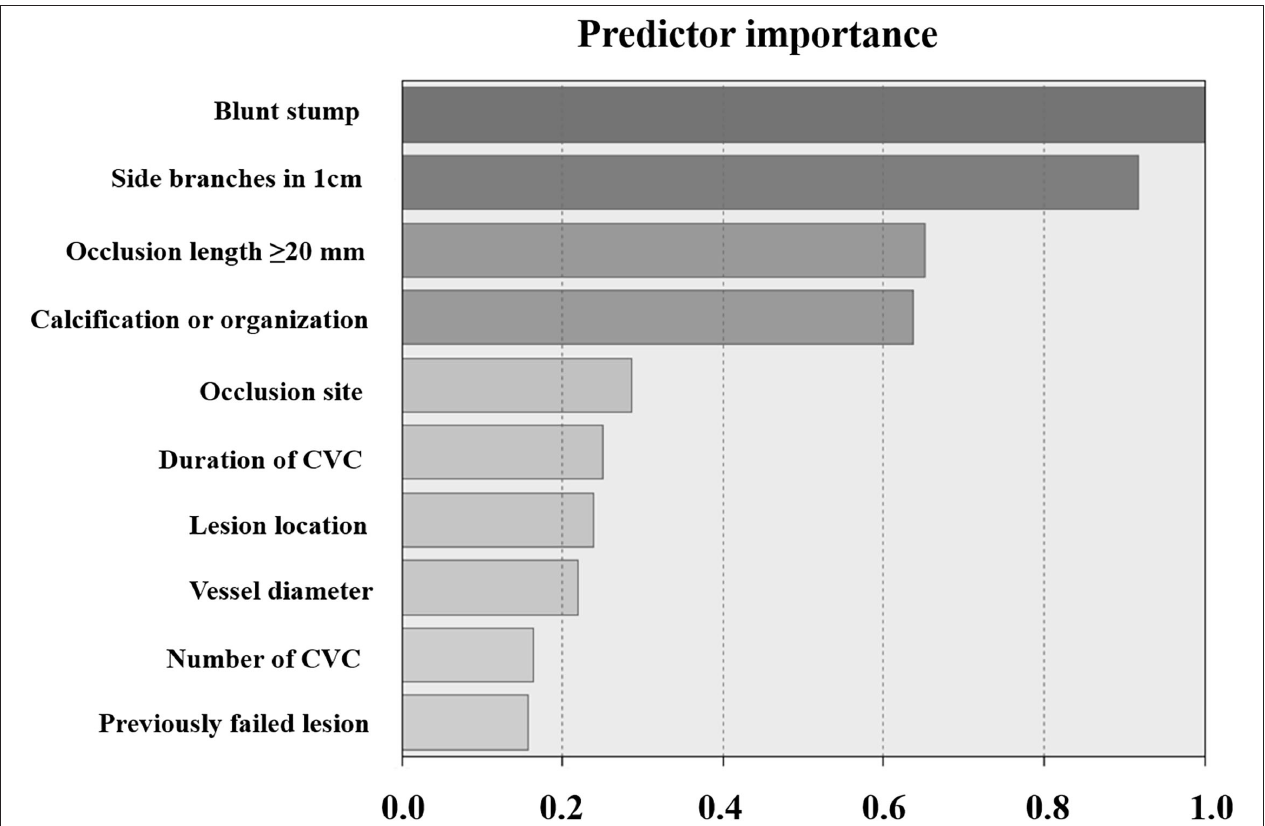
FIGURE 3 | Schematic diagram of the predictor importance of various clinical characteristics in differentiating the clusters. The higher the value, the greater the importance of the factor for clustering.